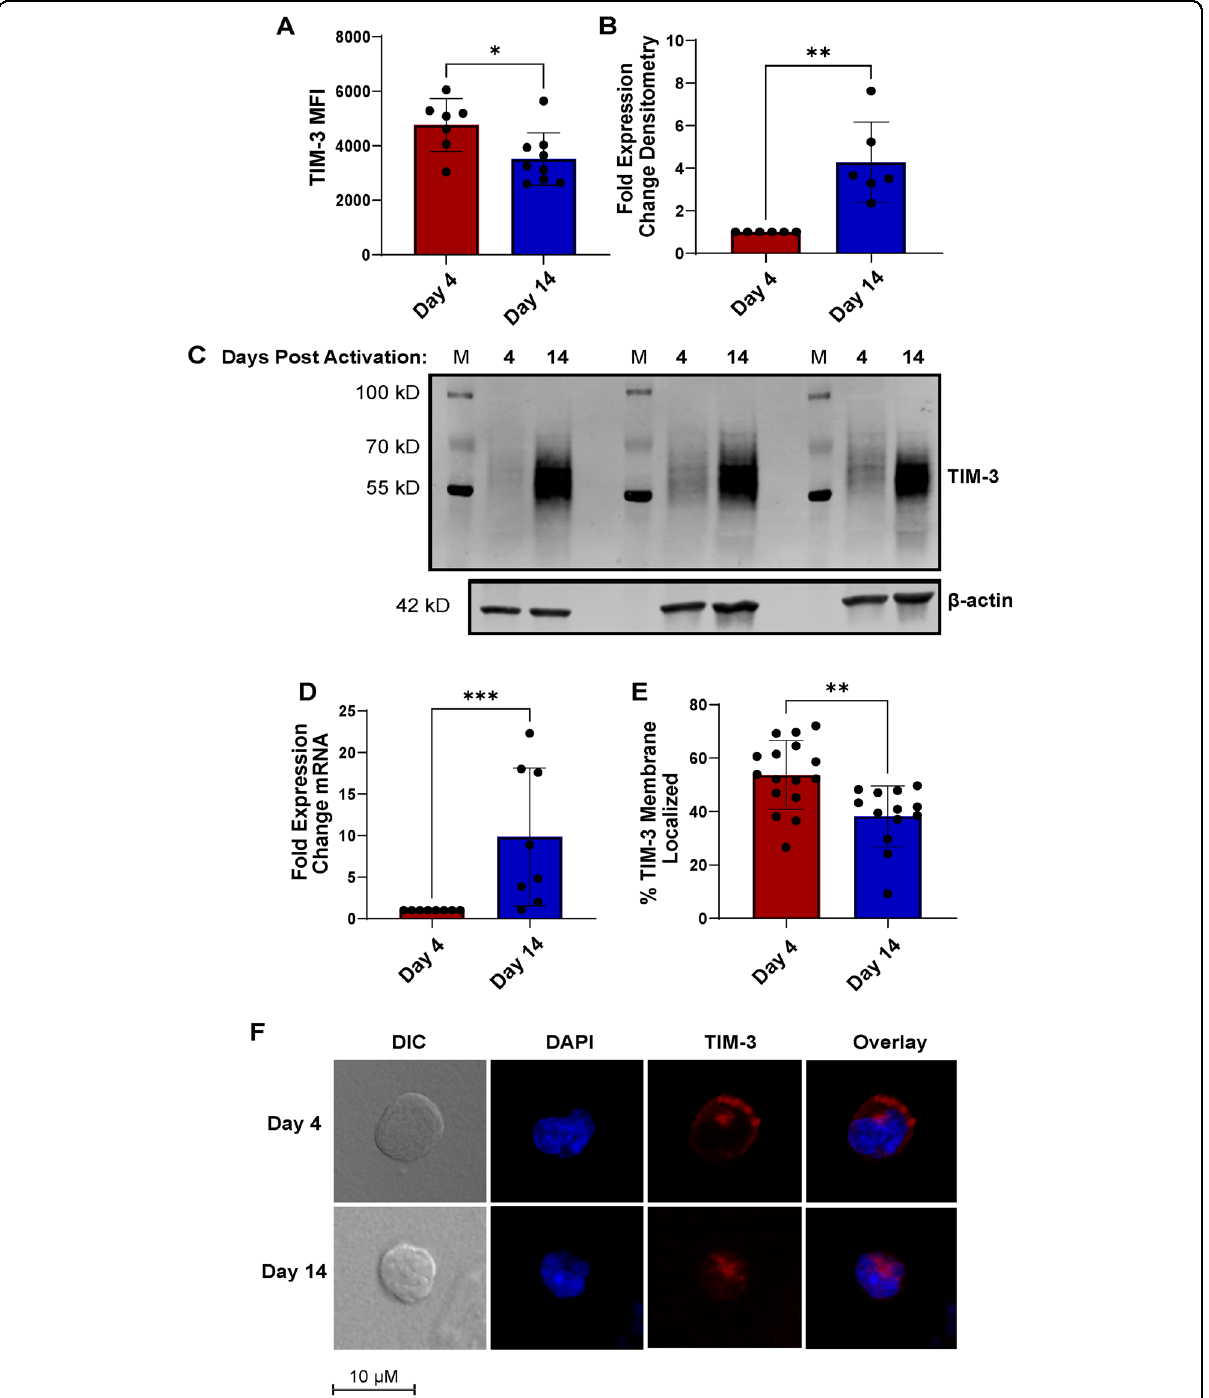
Fig. 3 TIM-3 localization in effector CD8 + T cells changes over time in culture. A Surface TIM-3 expression (MFI) was measured by fl ow cytometry for early stage (day 4) and late-stage (day 14) effector T cells. B Total TIM-3 protein expression was quanti fi ed by spot densitometry of western blots, normalized against β -actin, plotted for each donor from early vs. late-stage T cells. C Representative western blot of three donors tested for total TIM-3 expression, as quanti fi ed in ( B ). M = marker. D TIM-3 mRNA expression was assessed by qPCR on day 4 and day 14 post- activation, with normalization against 18S rRNA. E Protein localization was quanti fi ed by confocal microscopy using ImageJ (see “ Methods ” section for code), in which 2 – 4 single cells from 6 individual donors (each point represents a representative cell from a different donor) on day 4 and day 14 were assessed for % TIM-3 distribution around the cell. F Representative images of single cells from days 4 and 14 post activation, as quanti fi ed in ( E ). Asterisks denote statistical signi fi cance using the following tests: A t test, p = 0.0229; B Mann – Whitney test, p = 0.0002; D Mann – Whitney test, p = 0.0022; E paired t test, p =